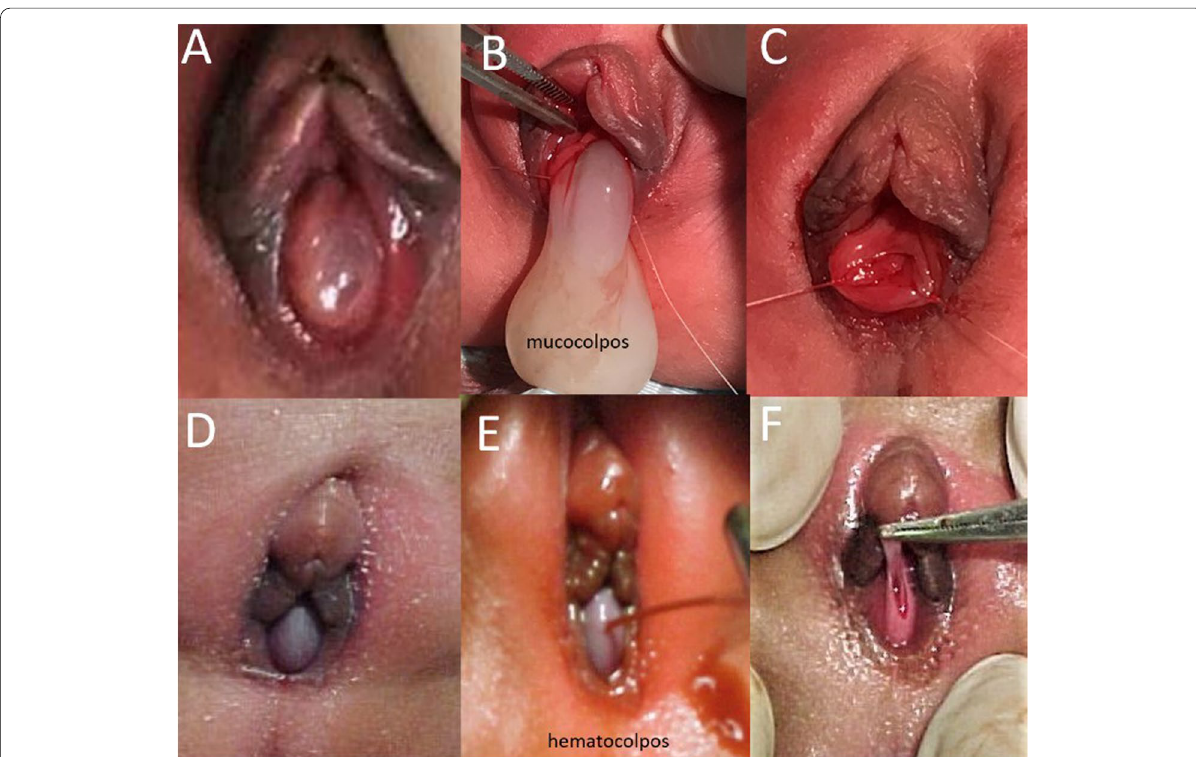
Fig. 2 Neonate imperforate hymen (IH). A White bulging IH pre-incision. B Drained thick white mucous upon hymenotomy. C Completed primary HSCAH. D Blue bulging IH pre incision. E Drained retained neonatal menstruation blood upon hymenotomy showing the high intraluminal genital